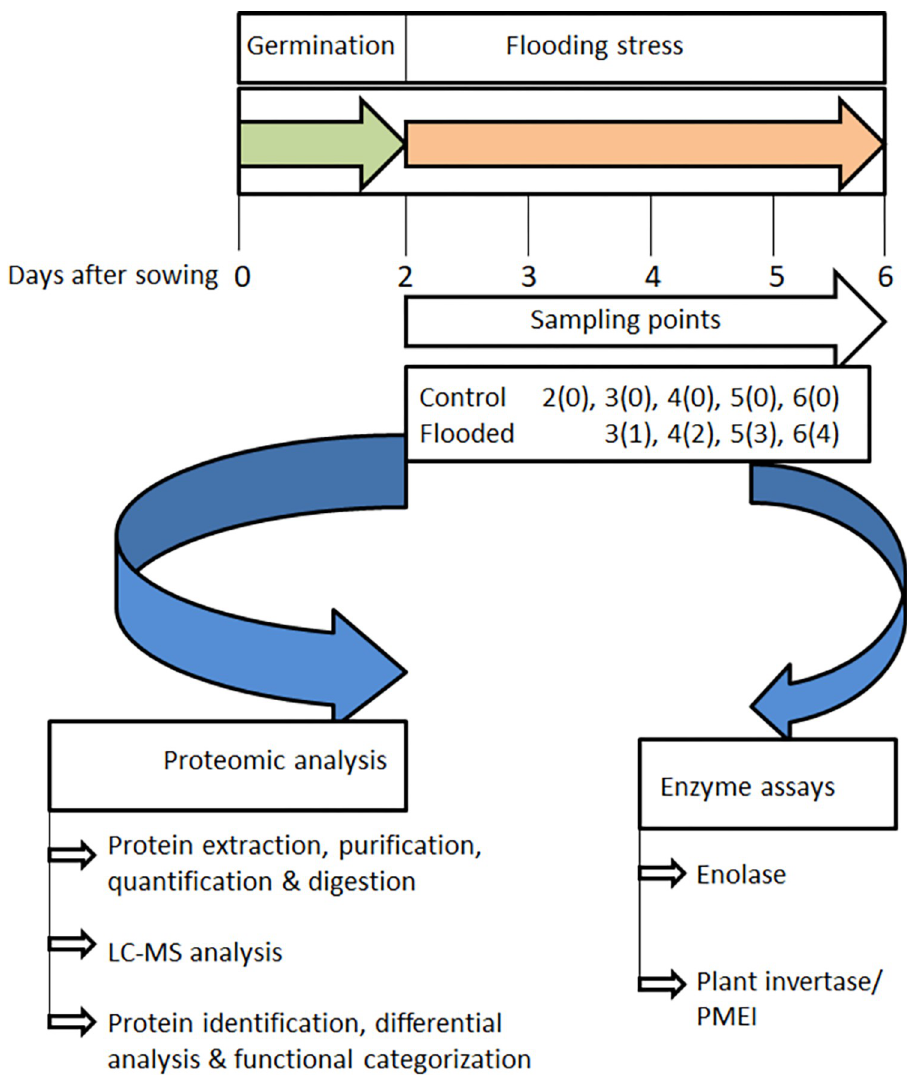
Fig 1. Experimental design of the